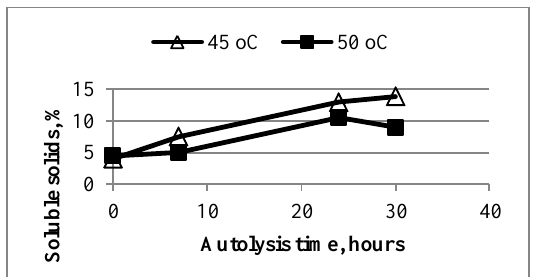
Fig. 1. The soluble solids content of Yeast extract during